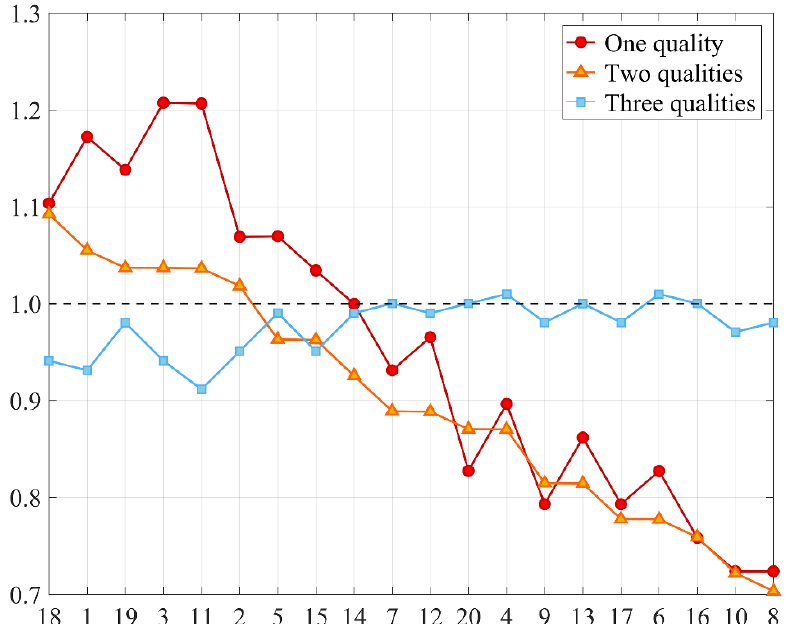
Figure 6. The variation of the area ratio of different seawater quality to the corresponding value in the control experiment. (One quality: worse than Grade IV, Two qualities: Grade IV and worse than Grade IV, Three qualities: Grade III, Grade IV and worse than Grade